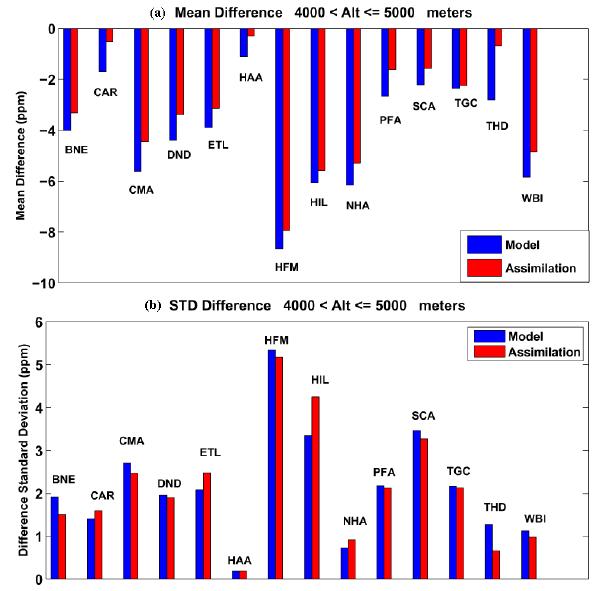
Fig. 11. Mean (a) and standard deviation (b) differences (O − M or O − A) between NOAA/CMDL aircraft measurements and model (blue) or analysis (red) fields interpolated to observation locations, for the period February–May 2006, and for measurements between 4000 to 5000m. The sites used here are the same as those in Figs. 8 and 9, except for some which had too few measurements available during this period for calculating the standard